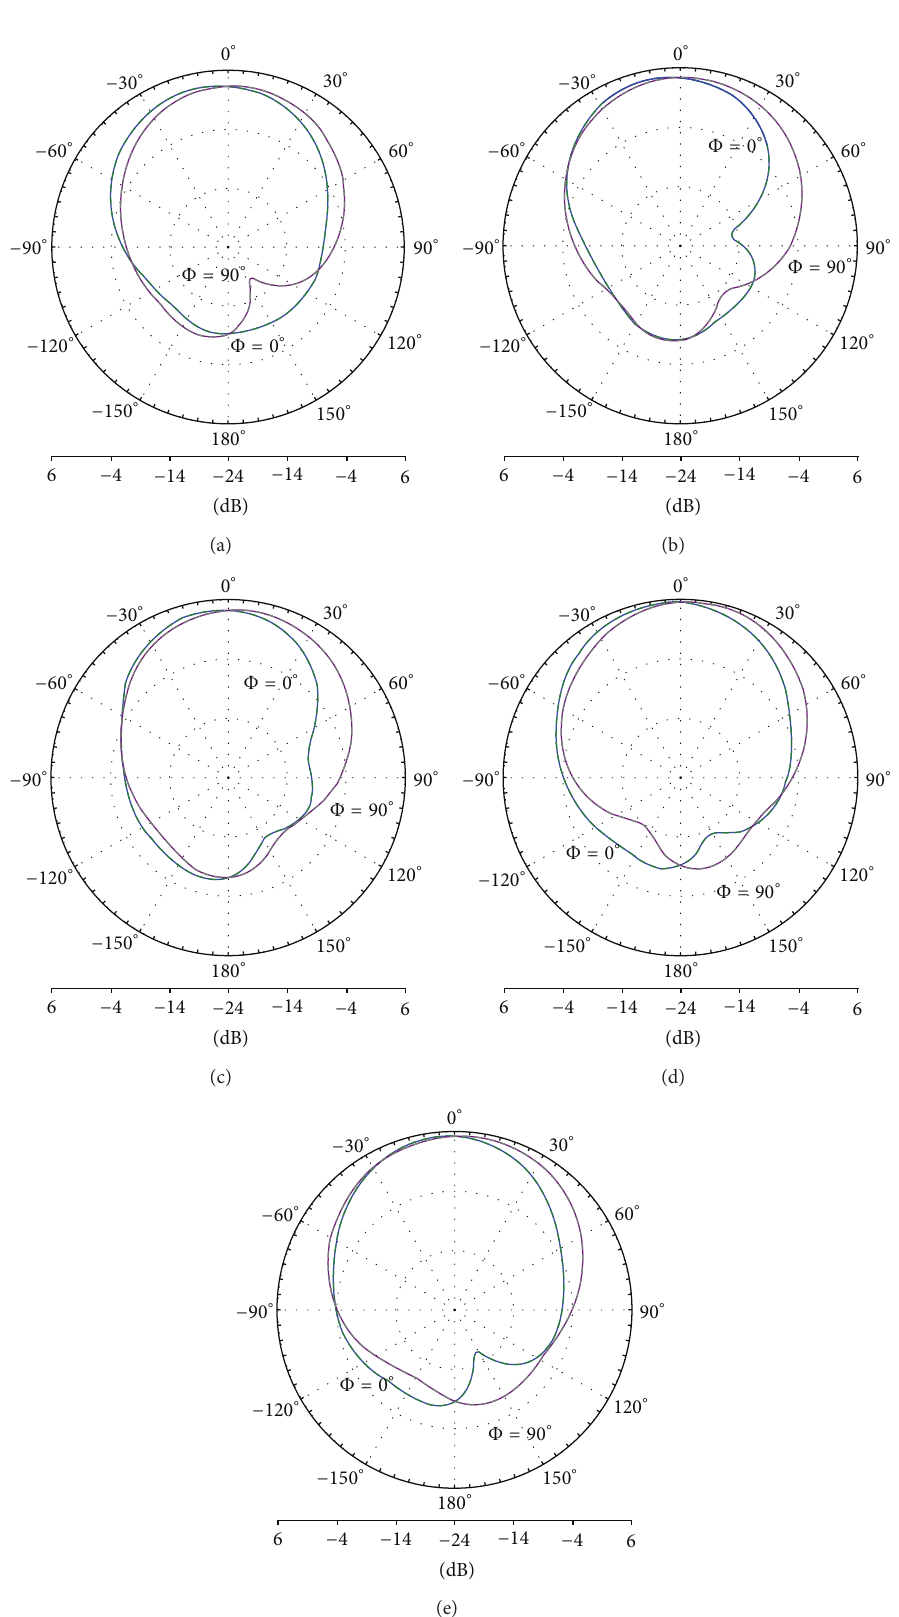
Figure 6: Radiation patterns at the center of each band. (a) GSM1800 ( 𝑓 = 1800 MHz). (b) GSM1900 ( 𝑓 = 1920 MHz). (c) UMTS ( 𝑓 = 2040 MHz). (d) LTE2300 ( 𝑓 = 2350 MHz). (e) Bluetooth ( 𝑓 = 2440